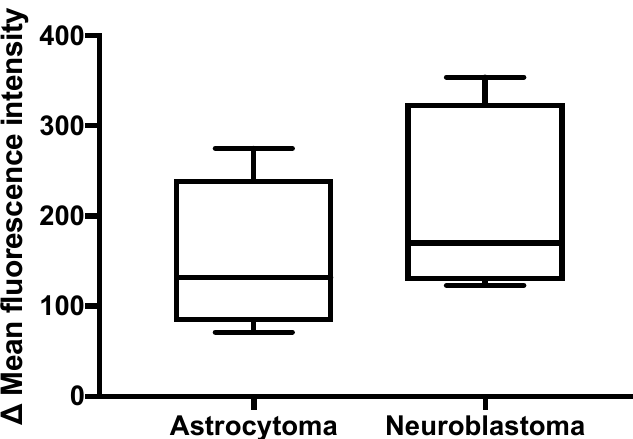
Figure 1. Low-density lipoprotein receptor (LDL-R) expression was measured by flow cytometry. Delta ( Δ ) in mean fluorescence intensity (MFI) from cells incubated with LDL-R anti-antibodies minus the MFI of cells without LDL-R anti-antibodies. Median and interquartile ranges of 75–25 are shown (Mann–Whitney test p -value 0.34) ( n = 6).